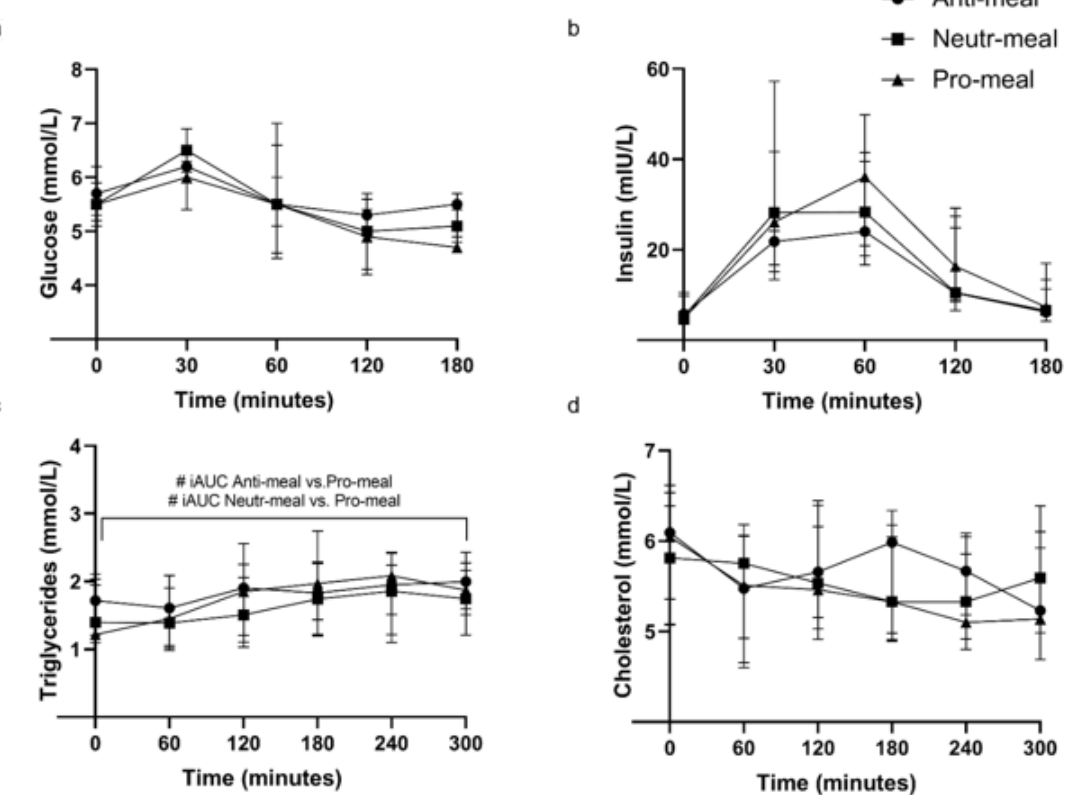
Figure 4. Postprandial ( a ) plasma glucose, ( b ) plasma insulin, ( c ) serum triglycerides, and ( d ) serum total cholesterol concentrations after ingestion of Anti-meal, Neutr-meal or Pro-meal. Data are presented as median ± IQR ( n = 11). # p < 0.05 by Friedman test followed by pairwise comparisons using Wilcoxon signed-rank test comparing iAUC between test meals. Abbreviations: Anti, anti-inflammatory; Neutr, neutral; Pro, proinflammatory.